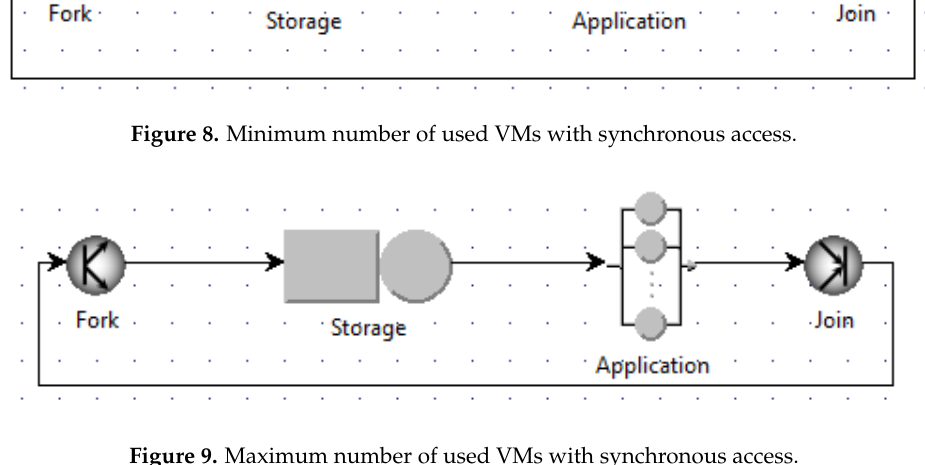
Figure 9. Maximum number of used VMs with synchronous